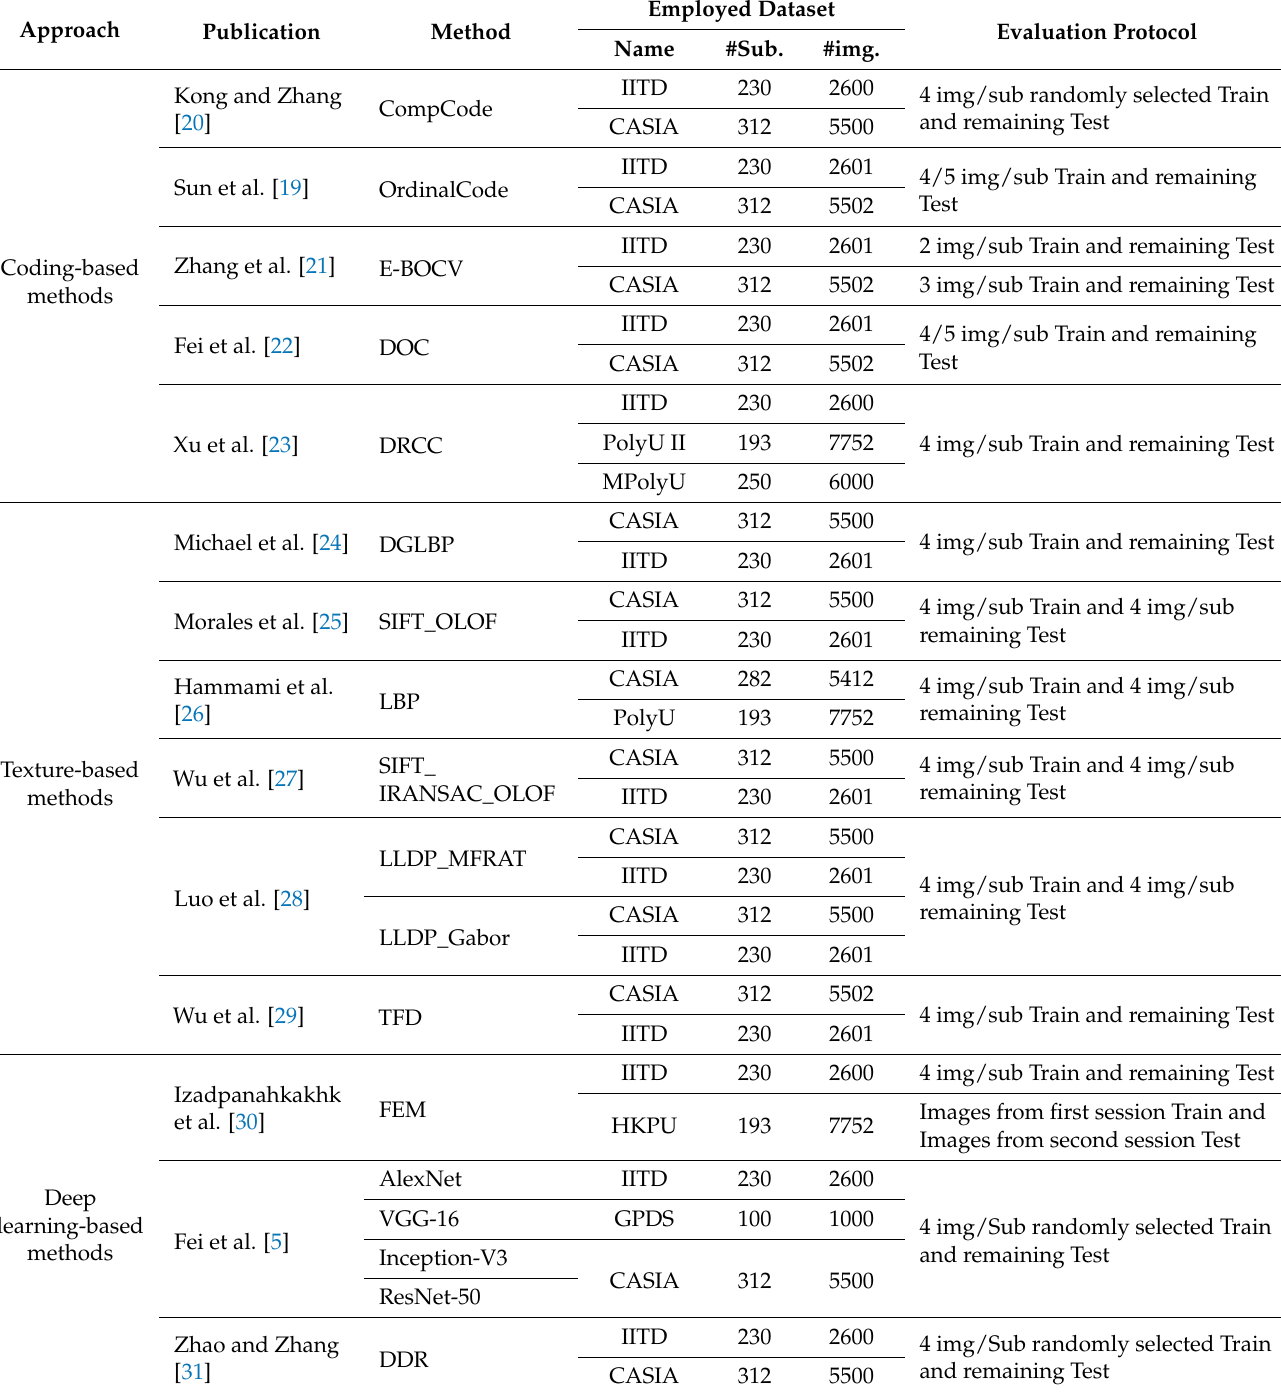
Table 1. Comprehensive summary of related work